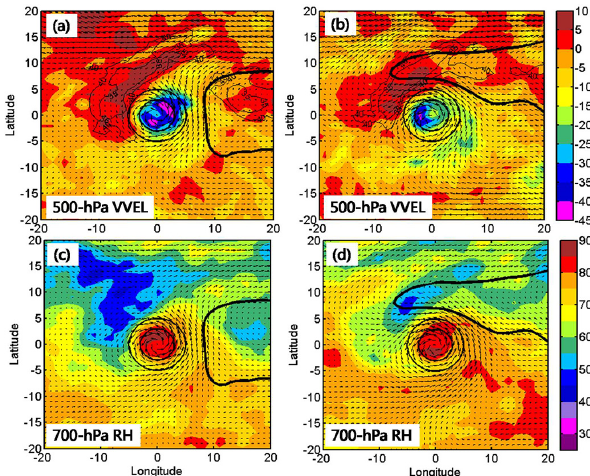
Figure 8. GFS-derived fields for the composites of vector winds and geopotential height of 5880m at 500hPa (thick black line) and (top) the 500hPa vertical velocity fields (in hPas − 1 , shading) and (bottom) the 700hPa RH (shading) for (left) weakening and (right) strengthening events at time t + 48h . Black contours are drawn at 40 and 35% 500hPa RH in the top panels. The two black solid circles are 3 ◦ - and 5 ◦ -radius circles centered on the